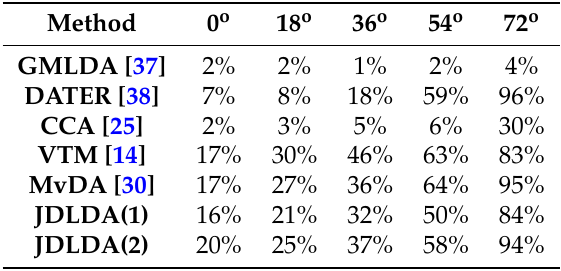
Table 1. Recognition performance of several gait recognition algorithms using the CASIA-B